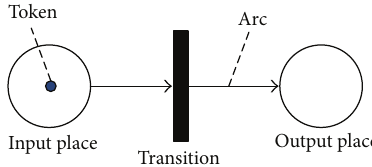
Figure 2: A simple PN and its